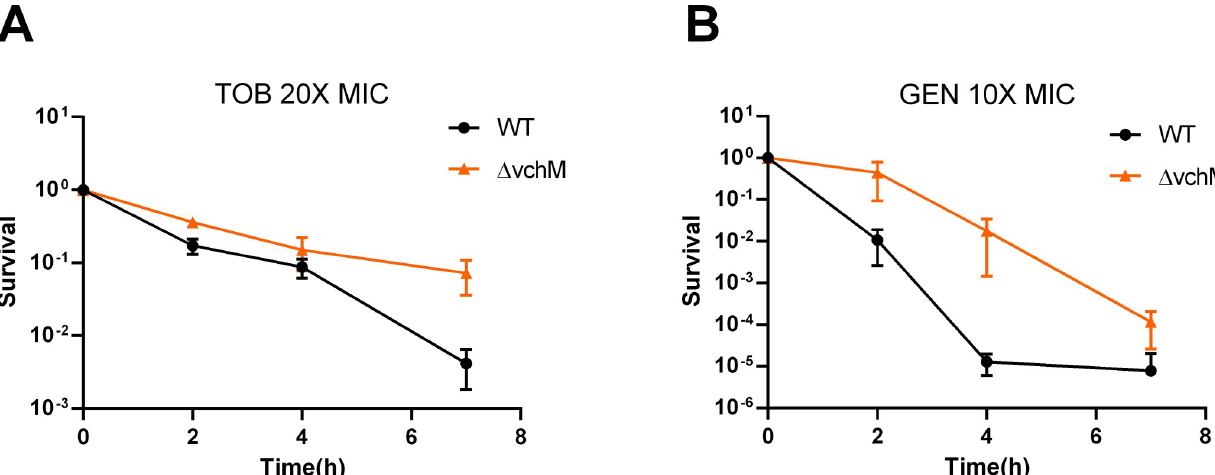
Fig 2. Δ vchM strain is more tolerant to lethal aminoglycoside treatment. Survival of stationary-phase WT and Δ vchM cells exposed to lethal doses of tobramycin (TOB) (A) , and gentamicin (GEN) (B) . Survival represents the number of bacteria (CFU/mL) after treatment divided by the initial number of bacteria prior treatment. Time in the X-axis represents the duration of the antibiotic treatment in hours. Means and SD are represented, n = 3.